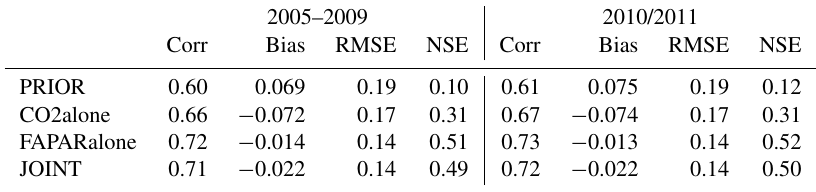
Table 4. Performance of the prior and posterior models compared with TIP-FAPAR observations (applying the same data quality screening as for the assimilation). The assimilation period (2005–2009) as well as a subsequent evaluation period (2010/2011) is shown. Abbreviations are Corr: correlation; Bias: Model – Observations; RMSE: Root mean squared error; NSE: Nash–Sutcliffe model